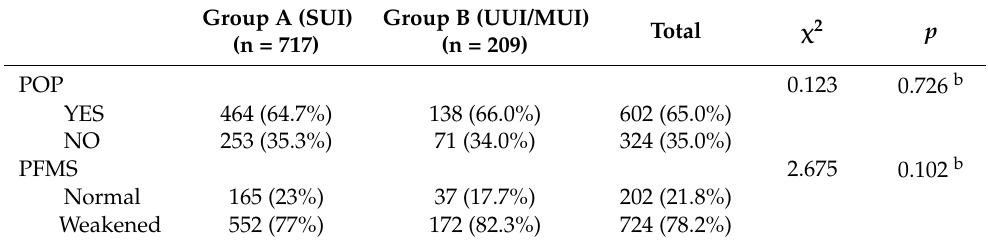
Table 3. PFMS and POP status in the two groups.